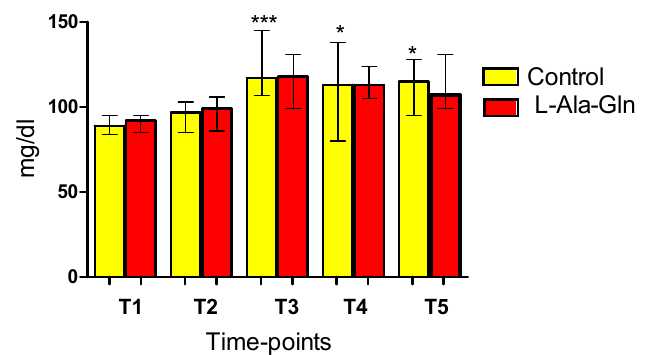
FIGURE 1 - Glucose concentrations (mg/dl) in the plasma of saline (control) and L-Ala-Gln-treated patients. Bars represent median with interquartile range of control (yellow bars) and L-Ala-Gln (red bars) groups during different time-points. Groups studied are not significantly different by ANOVA test (Friedman). Glucose levels increased in T3, T4 and T5 time-points compared with basal (T1) values,.*** P< 0.001 compared with T1 (control group); * P< 0.05 compared with T1 (control group).